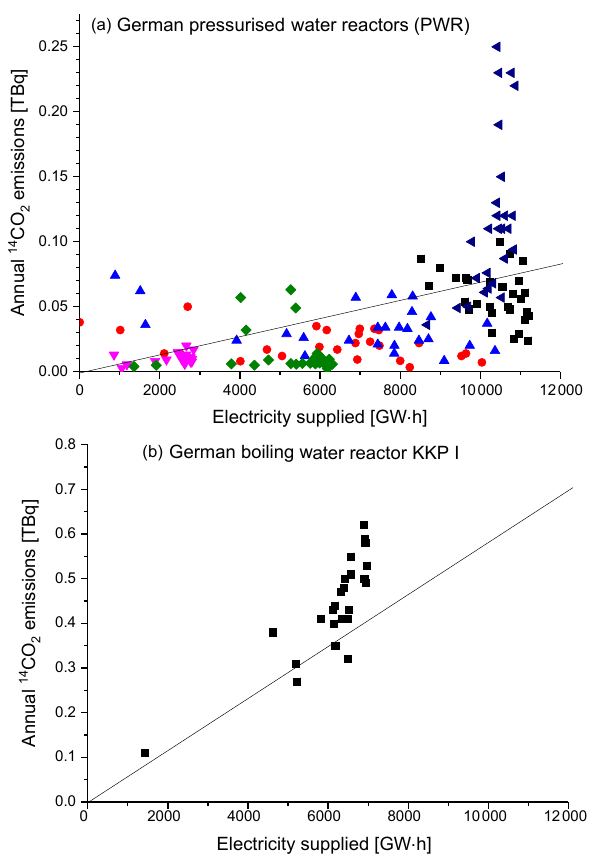
Figure 3. Relationship between annual 14 CO 2 emissions from Pres- surized Water Reactors (a) and the Boiling Water Reactor Philipps- burg I (b) and their annual electricity supplied. The solid lines show the specific emission factors reported by Graven and Gruber